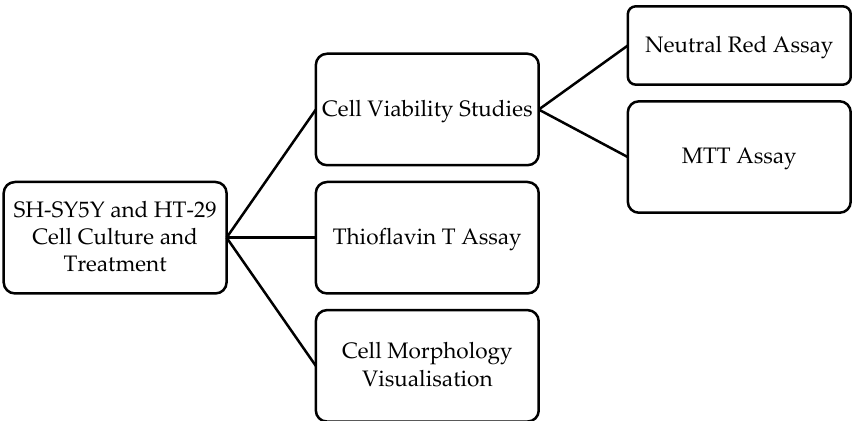
Figure 1. Summary of the methodologies used in this work.